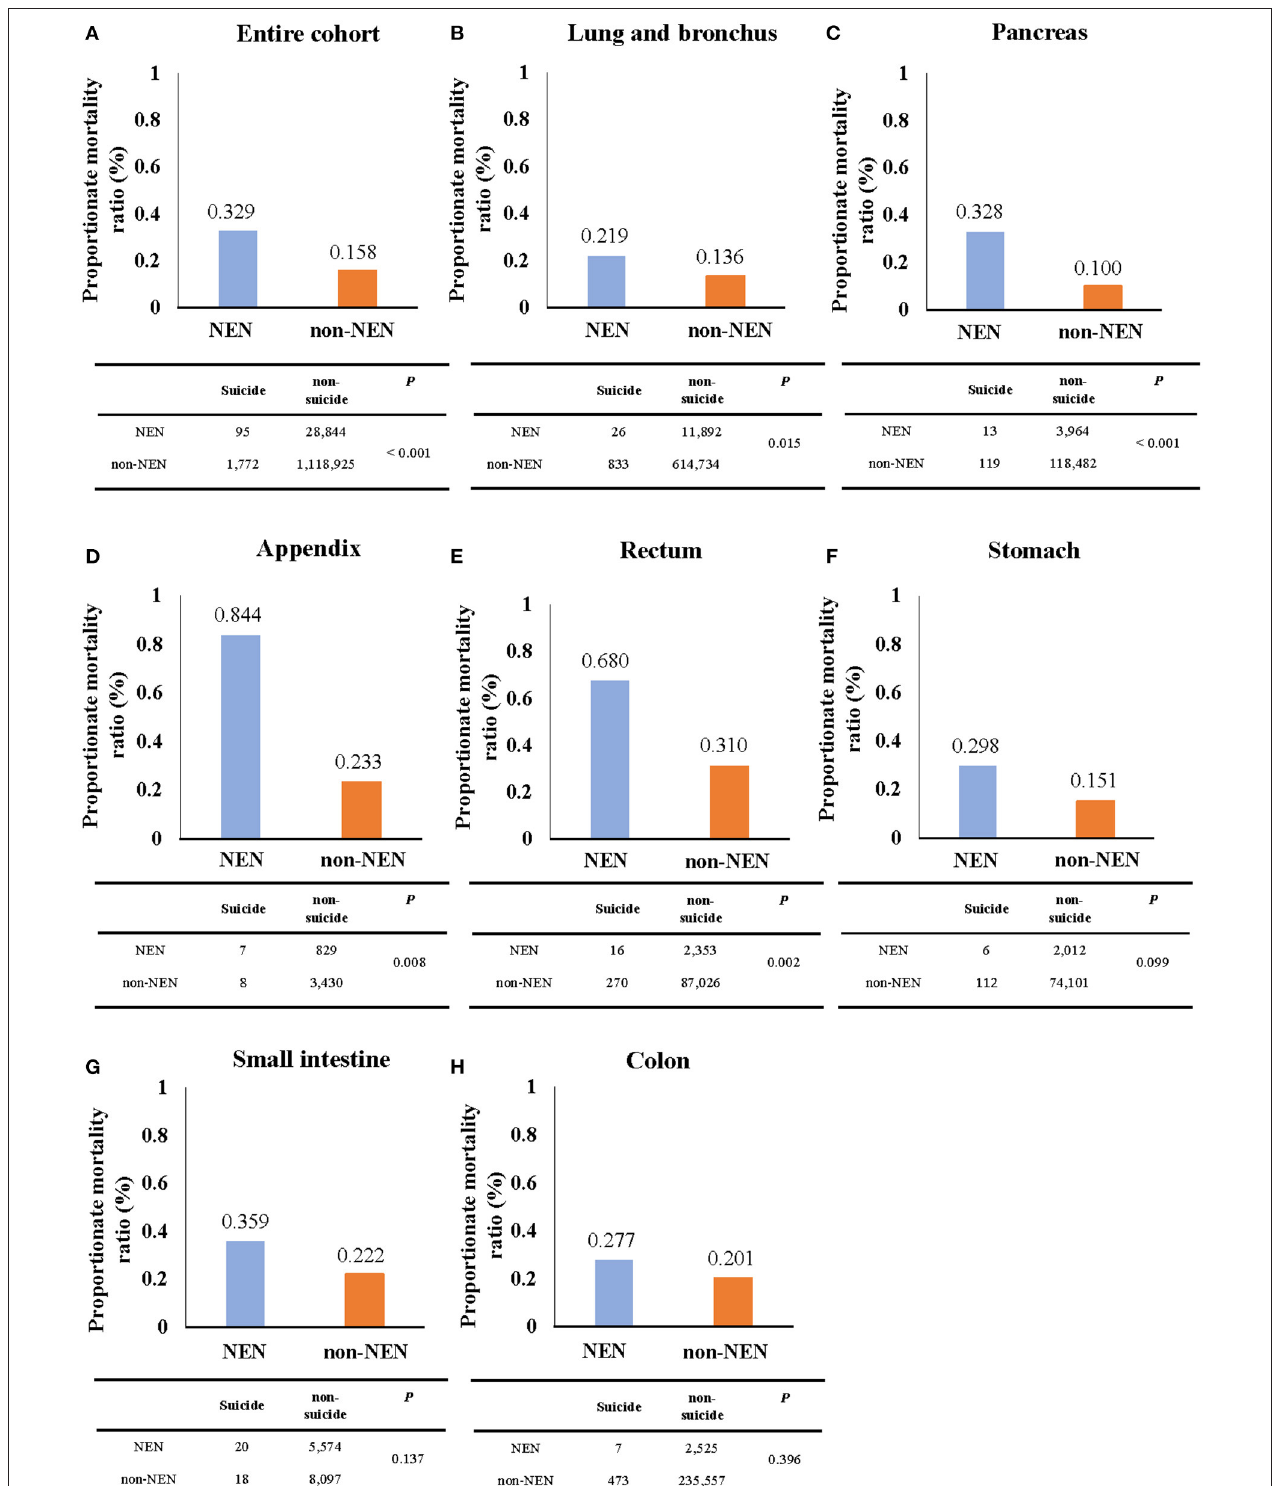
FIGURE 2 | The proportionate mortality ratio (PMR) of suicide. The PMR of suicide of NEN patients was significantly higher than that of non-NEN patients in cohorts with all listed types of cancer (A) as well as only lung and bronchus (B) , pancreatic (C) , appendix (D) , and rectum cancer (E) . However, no significant difference for PMR of suicide between NEN and non-NEN patients was found, when analyzing stomach cancer (F) , small intestine cancer (G) , and colon cancer cohorts (H) . The P -values were determined by Chi-squared test, and P < 0.05 indicates a significant difference.